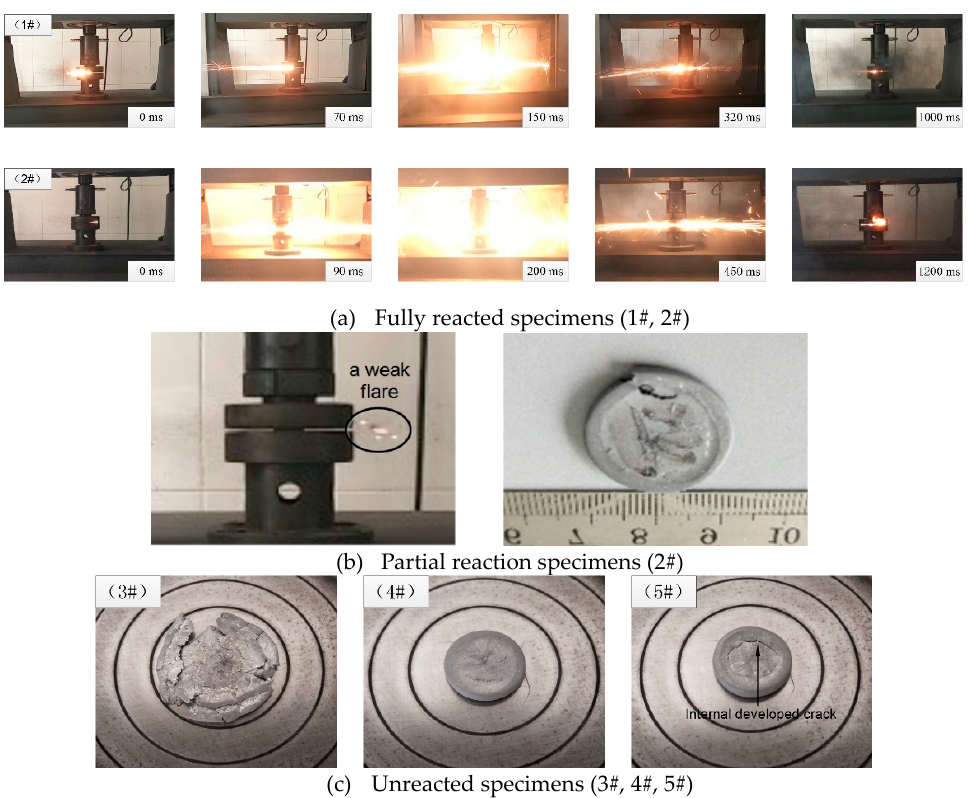
Figure 3. Reaction phenomenon of different specimens in quasi-static compression. ( a ) Fully reacted specimens, ( b ) Partial reaction specimens, ( c ) Unreacted specimens.